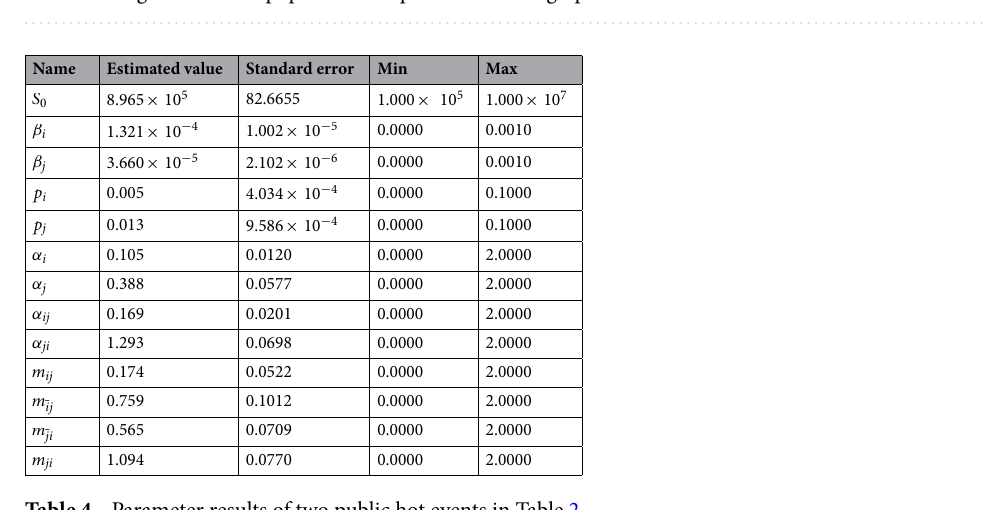
( t ) , F ¯ ( t ) , F ( t ) , F ( t ) , I ( t ) are represented by different colored lines, and similar ij ji i ¯ j j ¯ i